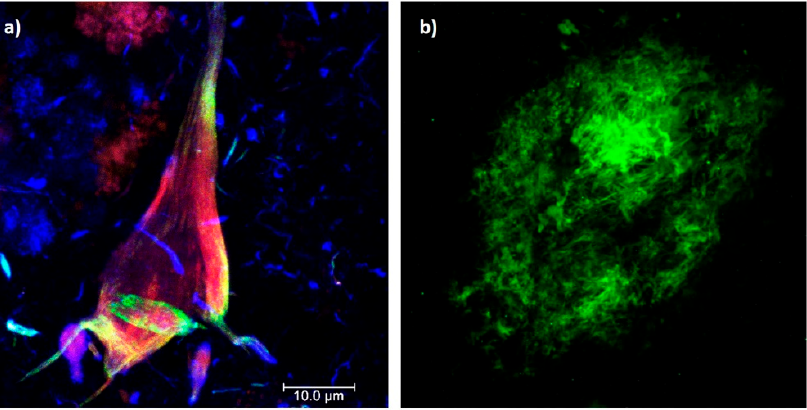
Figure 1. Histopathological hallmarks of Alzheimer’s disease. ( a ) Triple immunofluorescence showing a neurofibrillary tangle (conformational change: green channel; C-terminal tail: red channel; N-terminal of intact tau protein: blue channel). ( b ) Immunofluorescence showing an amyloid plaque (A β 1-40: green channel). Photomicrographs at 100X, calibration bar = 10 µm.